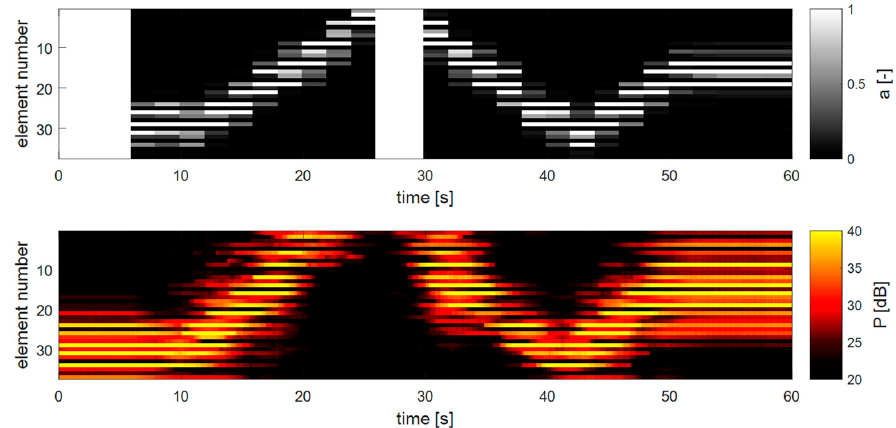
Figure 11. Dynamic apodization adaptation and received Doppler power during an in-vitro measurement. The flexible transducer array was curved during the experiment. After an initial time of 6 s, the DAA3 method with width D = 17.7 mm and λ = 0.2 mm − 1 was used.